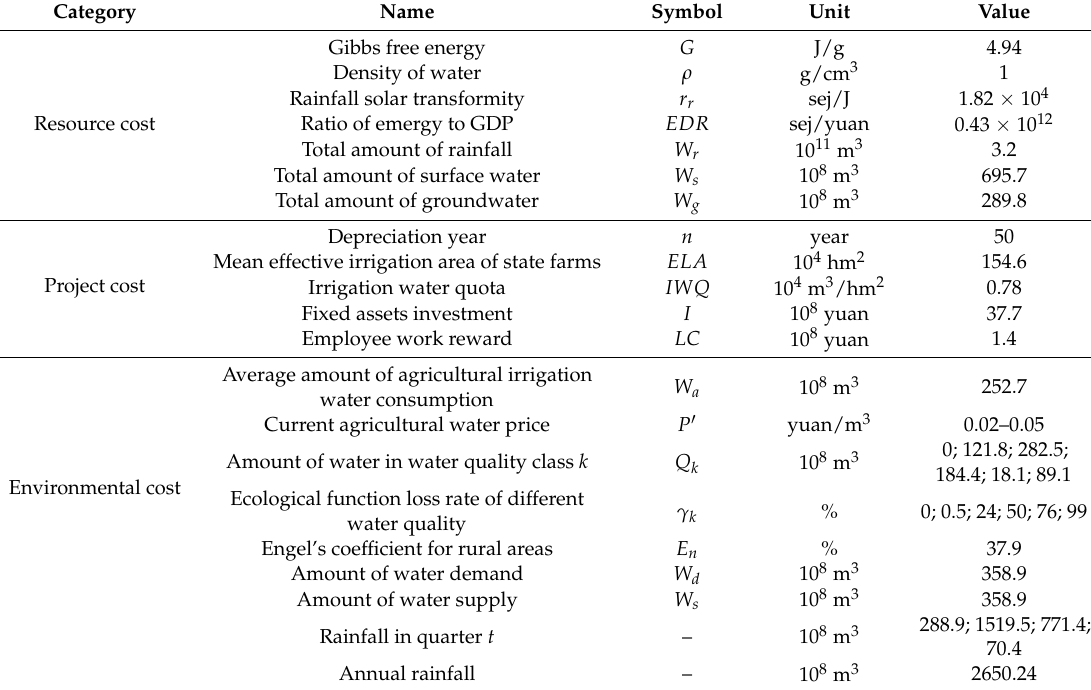
Table 2. Initial data for micro-agricultural irrigation water pricing. GDP, gross domestic product.